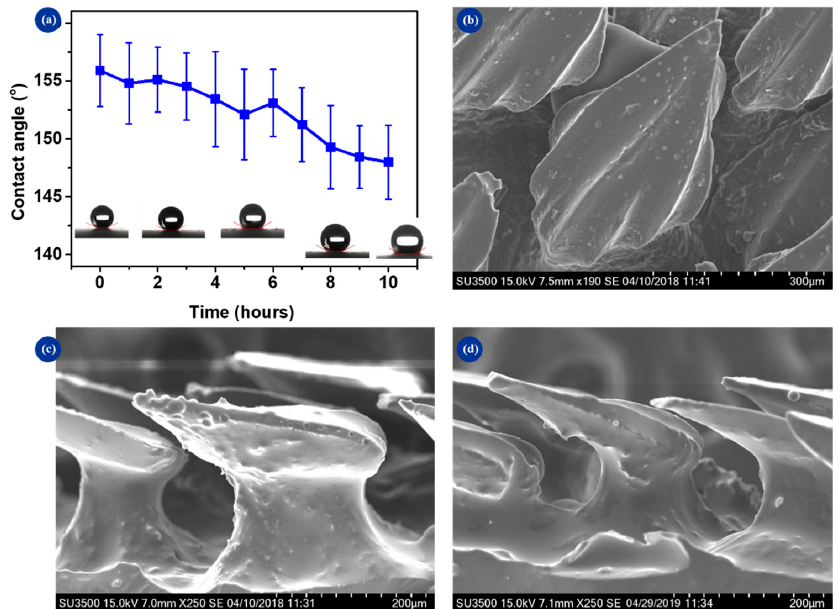
Figure 9. Durability of the biomimetic surface. ( a ) The evolution of contact angle with water impacting, ( b , c ) top and section views of the surface after 4 hours’ impacting, and ( d ) section view of the surface after 10 hours’ impacting. The sample of BSLS2 was used.